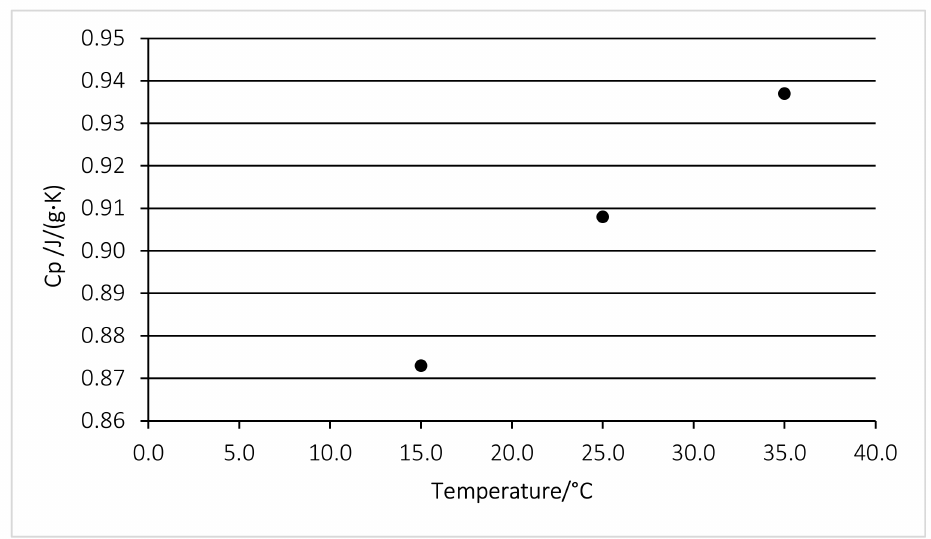
Figure 4. Thermal conductivity dependence on ambient temperature. In addition to thermal conductivity, specific heat was measured (Figure 5). Specific heat capacity Cp10 is 860 K/kg/K.